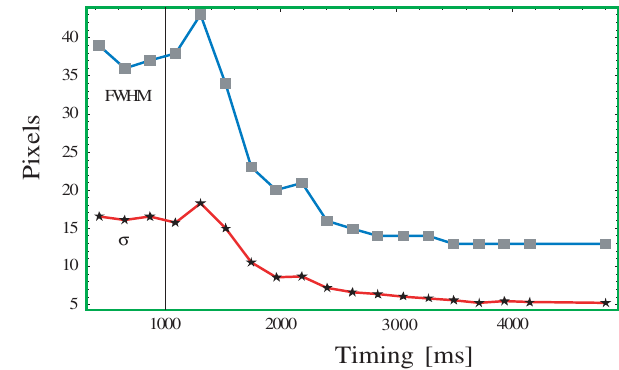
FIG. 7. (Color) Beam sizes evolution during the ramp ranging from 14 to 450 GeV.